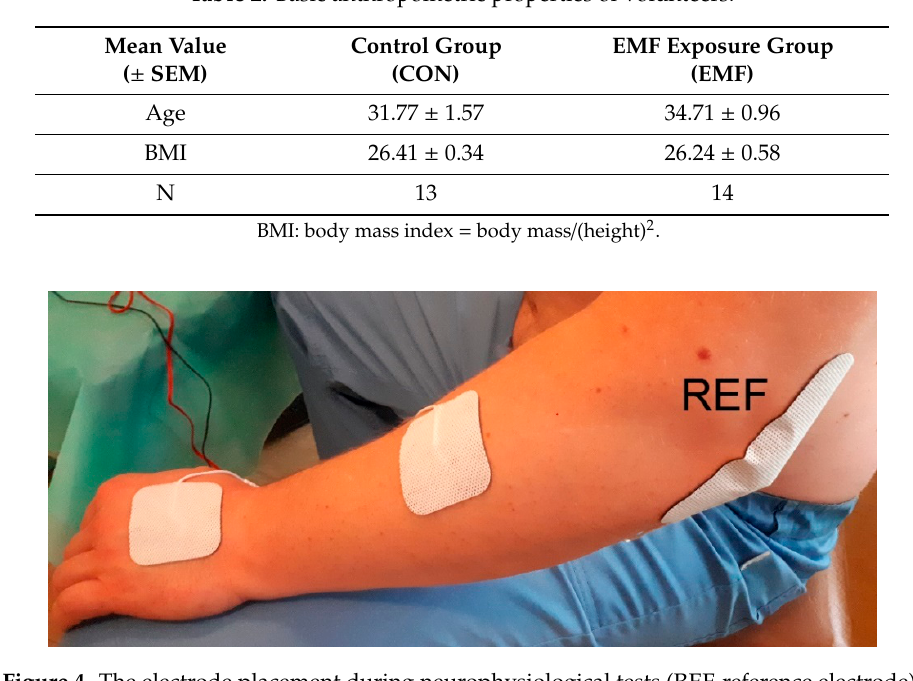
Figure 4. The electrode placement during neurophysiological tests (REF-reference electrode).